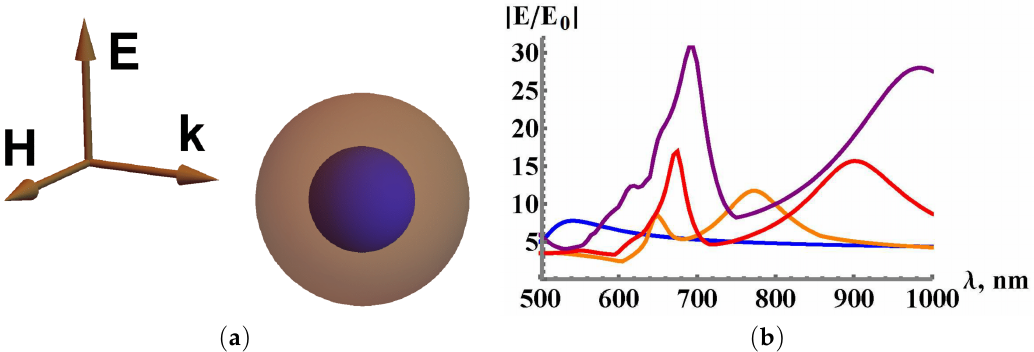
Figure 11. ( a ) scheme of the hybrid spherical resonator; ( b ) simulation electric field enhancement | E max / E | in the resonator (gold core) for different thicknesses ∆ of the dielectric shell. All the 0 parameters are available in [18]. The blue line corresponds to isolated Au particle without dielectric shell and the orange, red and purple lines correspond to isolated Au particle with a dielectric shell of the thickness ∆ = 50nm, ∆ = 100nm and ∆ = 150nm , respectively, reprinted with permission from [18], the Optical Society